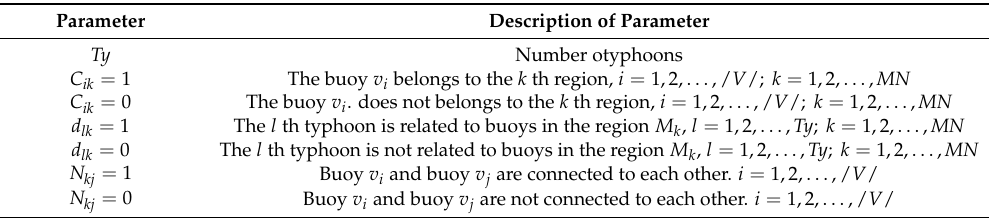
Table 1. Description of related parameters.